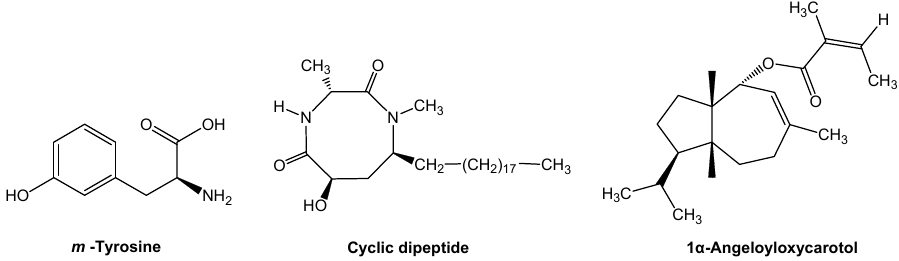
Figure 2. Novel allelochemicals from fine fescue grasses, Chinese fir and giant ragweed.